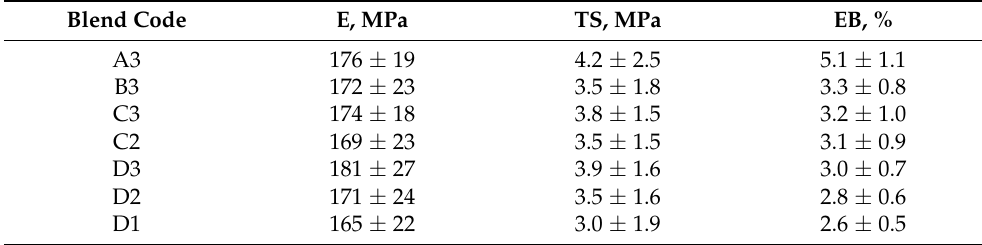
Table 10. Elastic modulus, E, tensile strength, TS, and elongation at break, EB, of all the investigated